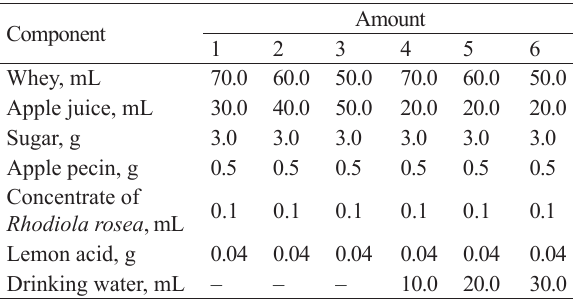
Table 1 Formulation of the whey drink fortified with Rhodiola rosea L.